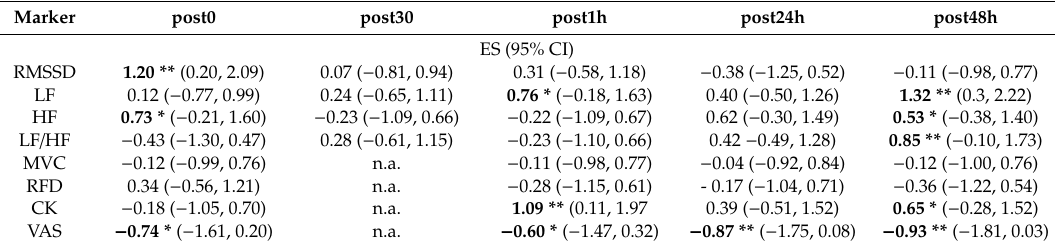
Table 1. E ff ect sizes (ES) between MAX and HYP for each acute time point in relation to the corresponding pre value.